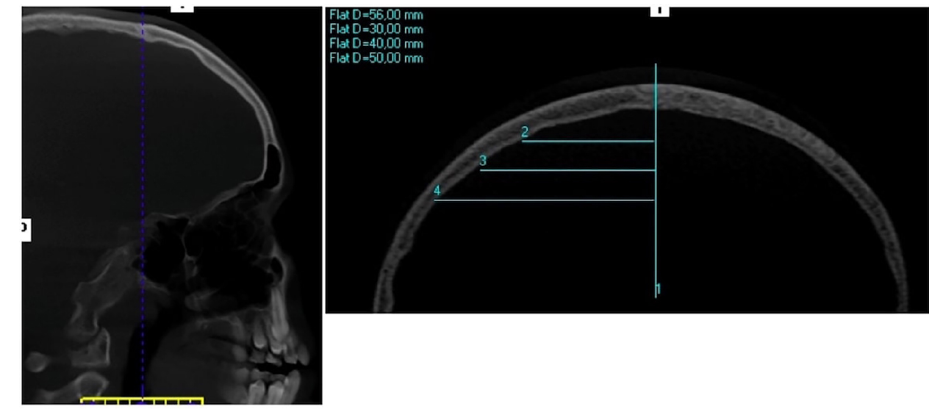
Figure 6- Blue line on the coronal suture. Guide for the measurement of bone thickness, 30, 40 and 50 mm to the right of the sagittal suture